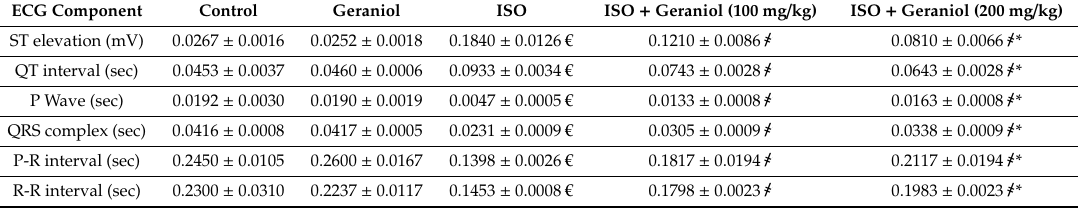
Table 2. The impact of geraniol pretreatment on ECG components in isoproterenol-induced myocardial infarction.